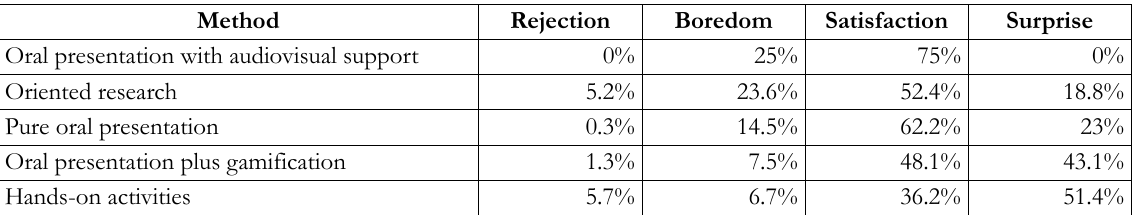
Table 3. The χ² test data for Teaching Method vs Main Emotion